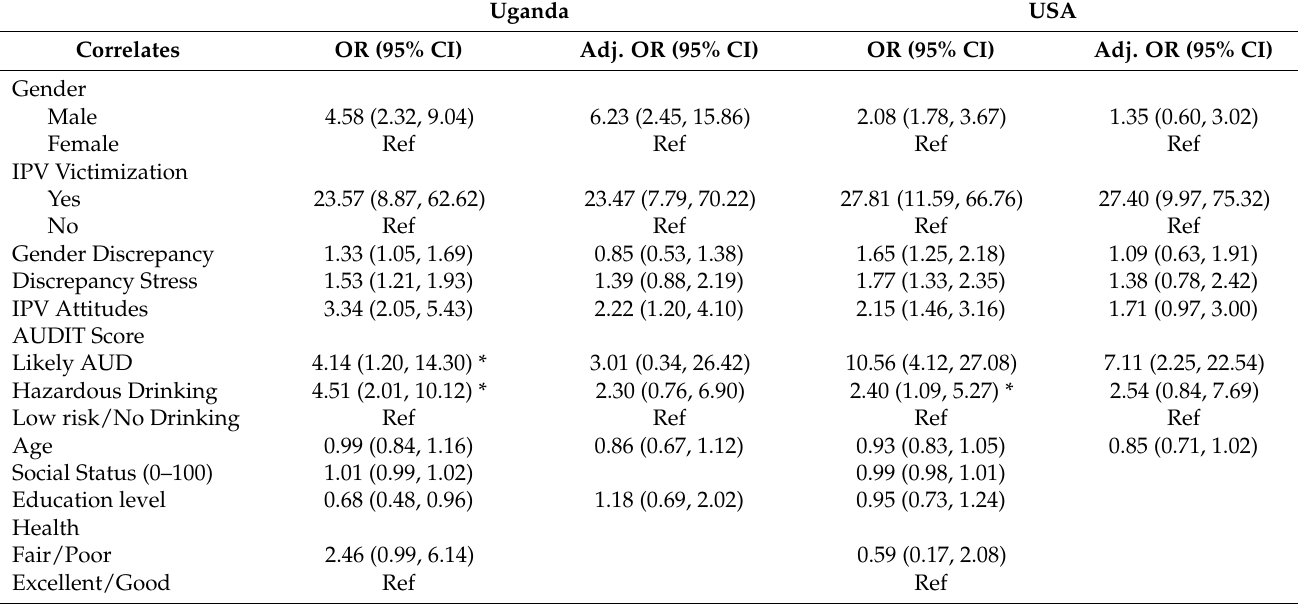
Table 3. Results of bivariable and multivariable logistic regression models predicting IPV perpetration (n = 408). Uganda